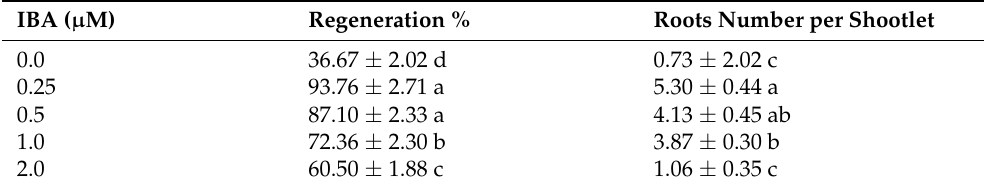
Table 5. Effect of IBA on in vitro root induction from microshoots of Plectranthus amboinicus .